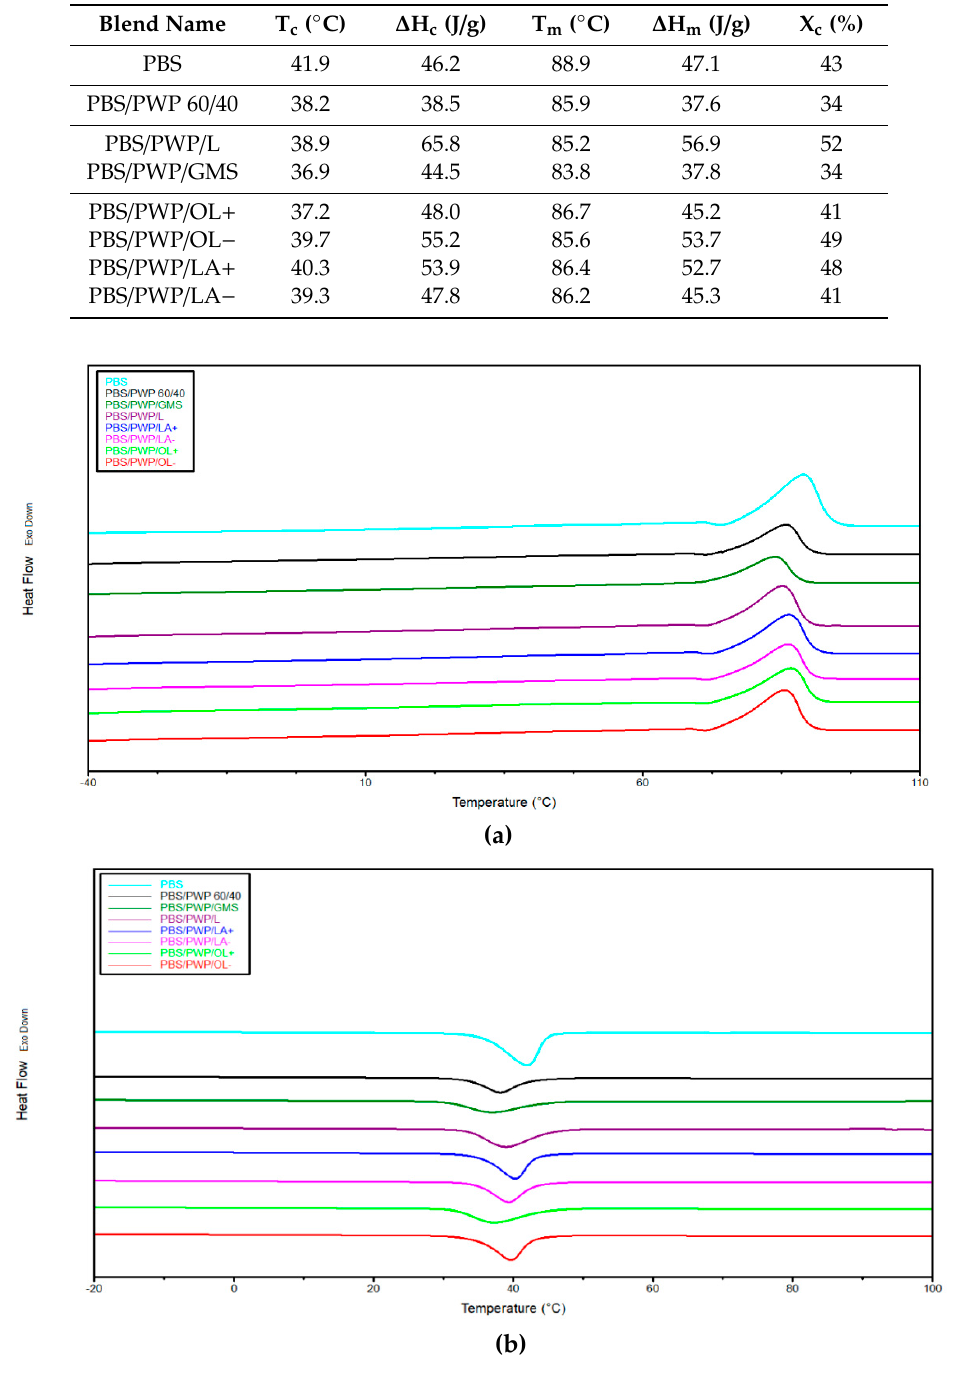
Figure 4. DSC thermograms for: ( a ) second heating and ( b ) cooling scan.